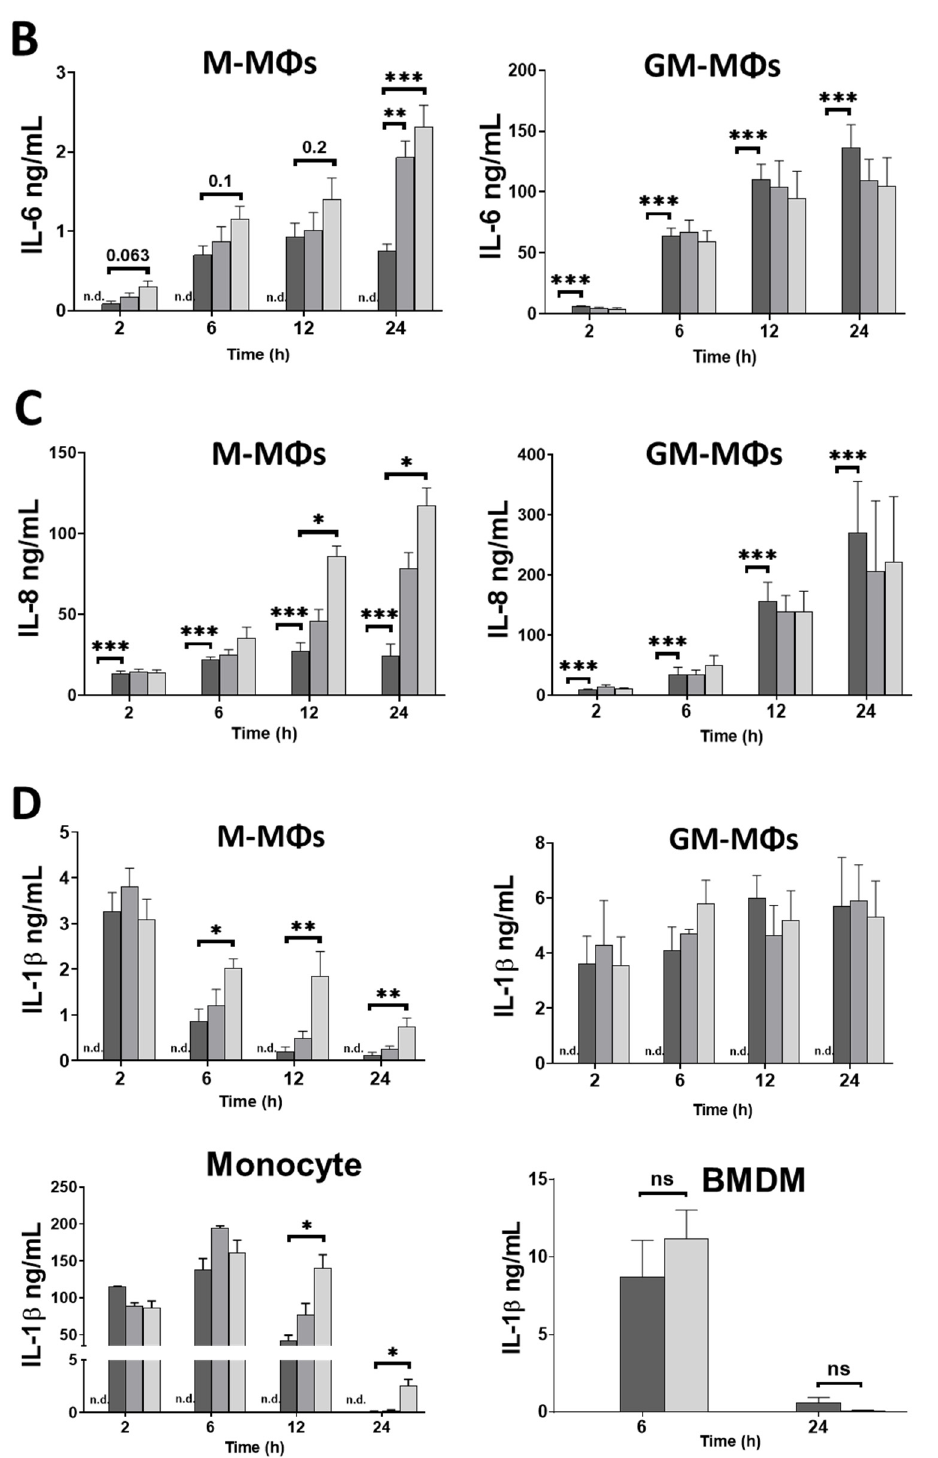
Figure 1. The modulatory effects of caffeine on cytokines secretion in different LPS-activated human myeloid cells. Cells were pre-treated with caffeine (0.3-1 mM) for 1 h, and then stimulated with LPS (100 ng/mL) for the indicated time. Cell culture supernatants were collected, and the secretion of ( A ) TNF- α , ( B ) IL-6, ( C ) IL-8, and ( D ) IL-1 β were measured by ELISA. For IL-1 β induction, cells were incubated with ATP (5 mM) for 45 min after LPS exposure. All results are shown as means ± SEM. (* p < 0.05, ** p < 0.01, *** p < 0.001).